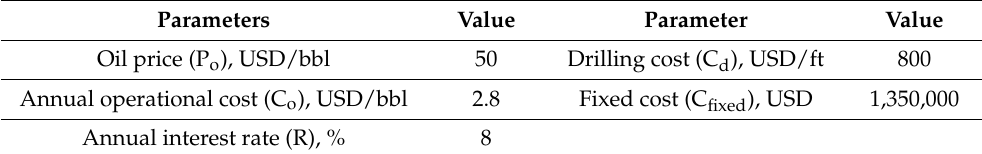
Table 5. Economic